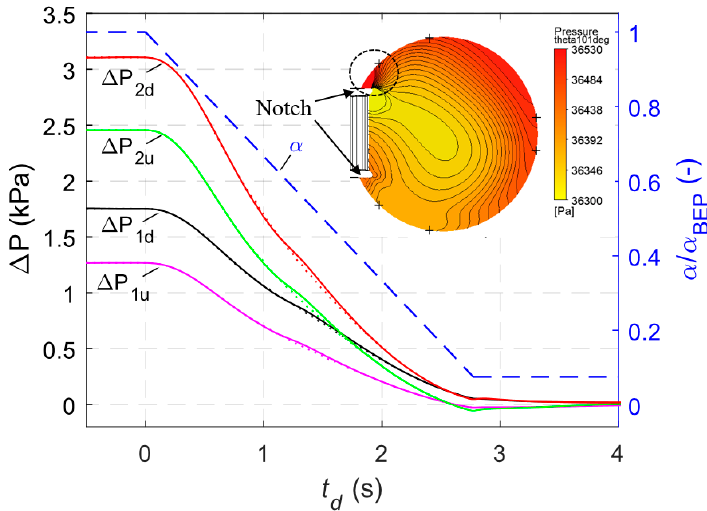
Figure 7. Variation of the pressure di ff erence ∆ P for the WK configurations at θ = 101 ◦ ; solid continuous lines: with ∆ t = 0.0226 s ( ∆ α = 0.2 ◦ / ∆ t ), dotted lines: with ∆ t = 0.0057 s ( ∆ α = 0.05 ◦ / ∆ t ). The continuous and dashed lines overlap. The pressure contours on a cross-sectional plane of the SC at θ = 101 ◦ at t d = 2.58 s is also shown in the figure. The plus signs ( + ) marked on the figure are the locations of the pressure points. A larger pressure is built up around P 2u point, marked with the dashed circle, near the upper notch region. Energies 2020 , 13 , 1310